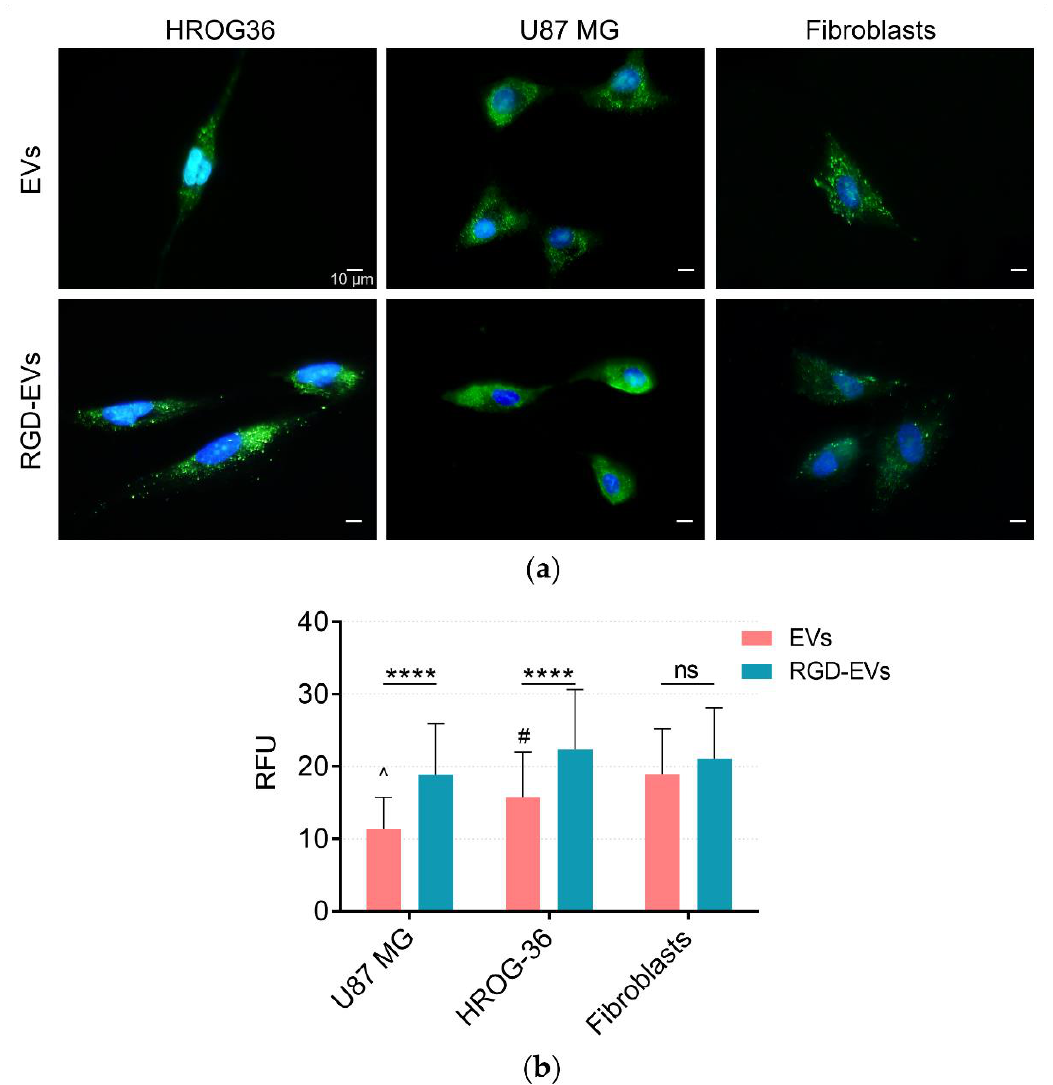
Figure 3. Tracing of EV uptake by HROG36, U87 MG and human fibroblast cells. ( a ) Representative fluorescence microscopy images of EV internalisation. Green fluorescence represents labelled RNA transferred to the cells by EVs. Blue fluorescence—Hoechst nuclear dye. ( b ) Quantitative evaluation of fluorescence intensity, which corresponds to amount of EVs internalised by the cells. Results demonstrate better internalisation of RGD-EVs compared to unmodified EVs by GBM and fibroblast cells following 4 h treatment. In contrast, no differences between the accumulation of RGD-EVs and native EVs were observed in fibroblasts. However, fibroblasts internalised native EVs faster compared to GBM cells; such a difference was not observed with RGD-EVs.; **** p < 0.0001 and # p < 0.05 when compared to fibroblasts; ˆ p < 0.0001 when compared to fibroblasts; ns—not